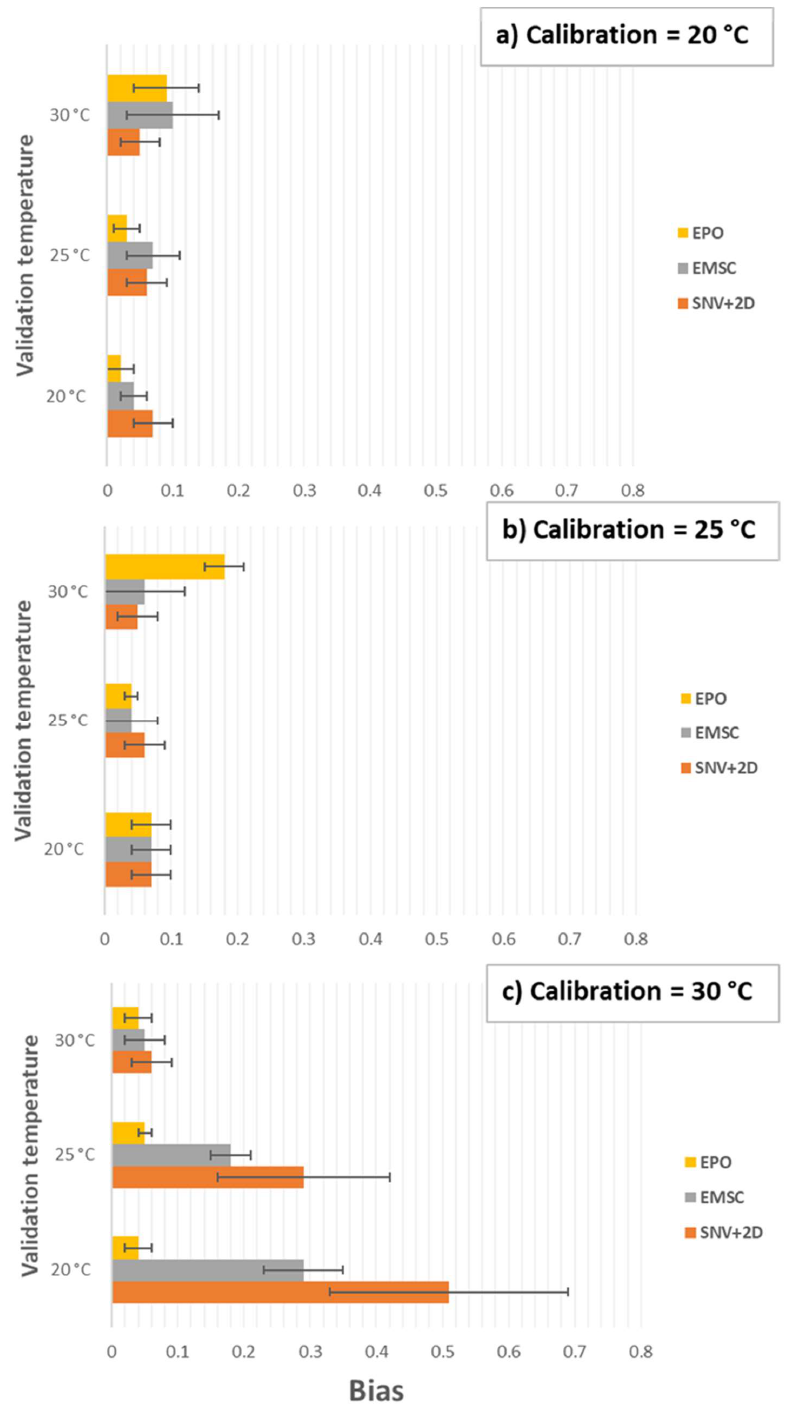
Figure 10. Validation temperature vs. bias for SSC prediction of kiwifruit juice in the second overtone (870–1100 nm) region of the OH stretch of water at calibration temperature ( a ) 20 ◦ C, ( b ) 25 ◦ C, and ( c ) 30 ◦ C. Error bars show standard deviation.